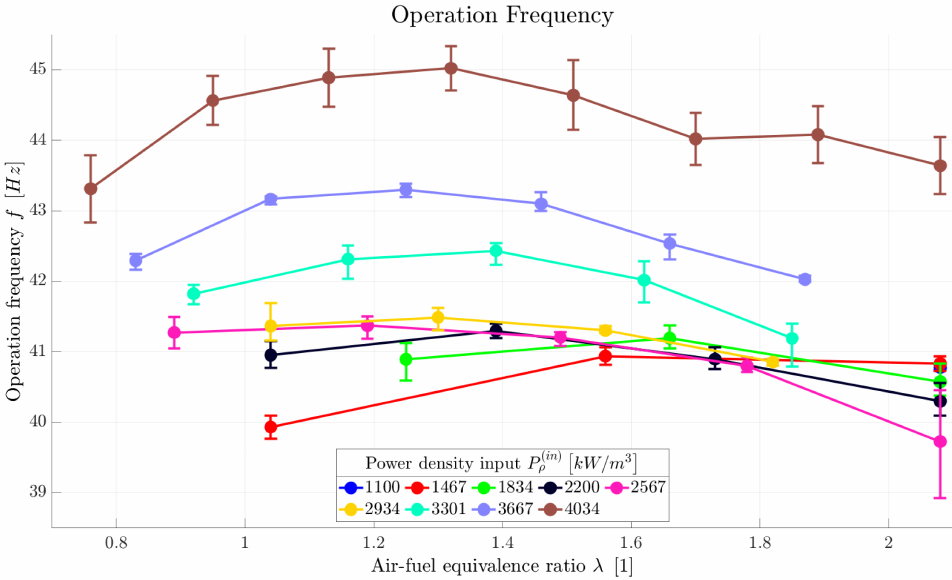
Figure 9. Operation frequency of a pulsation reactor displayed relative to air–fuel equivalence ratio for several power density input